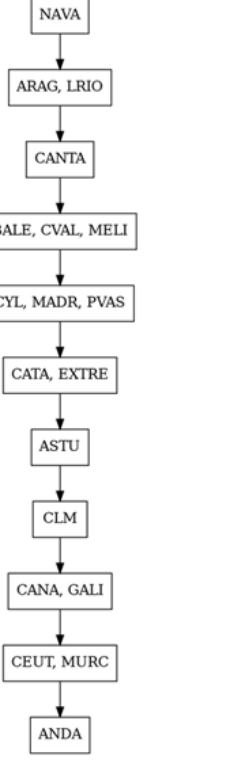
Figure 5. The ranking obtained using ELECTRE III.